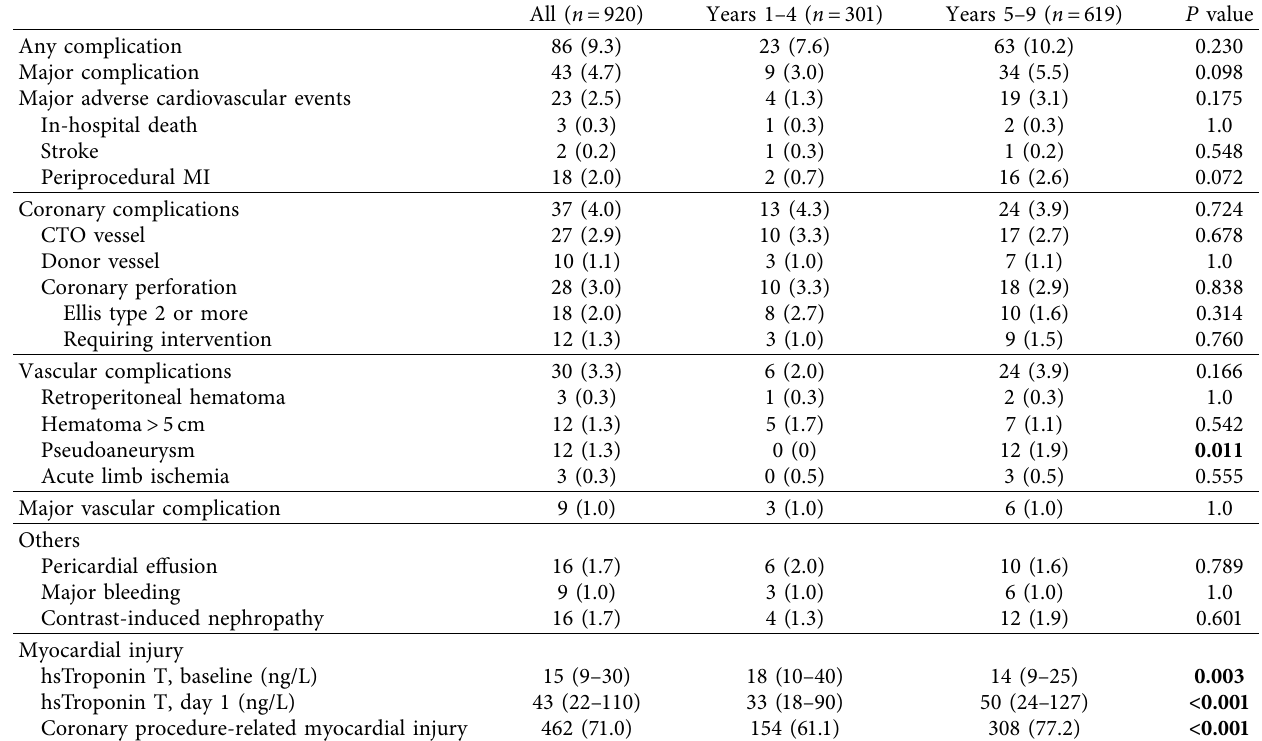
Table 2: In-hospital